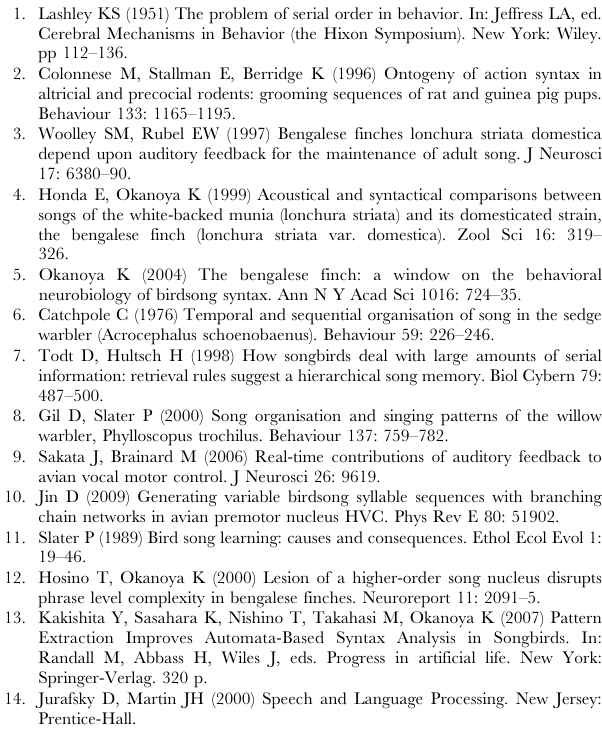
Figure S1 An example of deriving the POMM from observed sequences. a. The observed sequences generated by a POMM with three states, two states with symbol 1 and one state with symbol 2. b. The tree-POMM derived from 5000 observed sequences. c. The derived POMM after merging equivalent states in the tree- POMM. The original model used to generate the sequences shown in a are recovered. The diagram conventions are the same as in Fig. 2. Figure S2 The POMM for Bird 1. The POMM is derived with the syllable repetitions included. The conventions are the same as in Fig. 2. Figure S3 The POMM for Bird 2. The POMM is derived with the syllable repetitions included. The conventions are the same as in Fig. 2. Figure S4 Summary of the differences between sequences generated with the POMM and the observed sequences for the